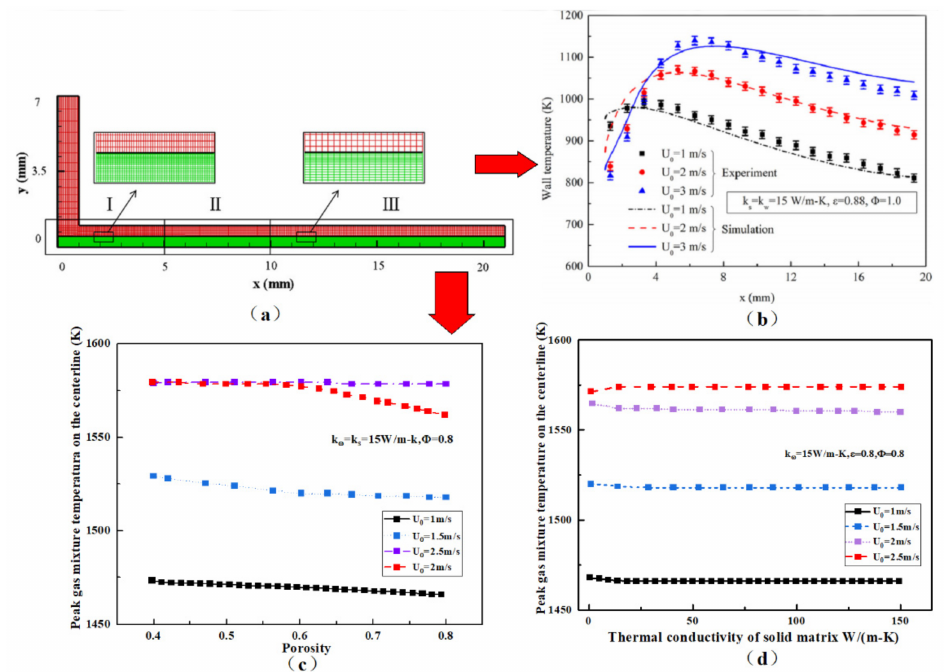
Figure 30. Effects of porosity and solid matrix thermal conductivity on flame temperature variation with inlet flow velocity. ( a ) Combustor grid, ( b ) Wall temperature, ( c ) Peak gas mixtrue temperature with different porosity, ( d ) Peak gas mixtrue temperature with different thermal conductivity of solid